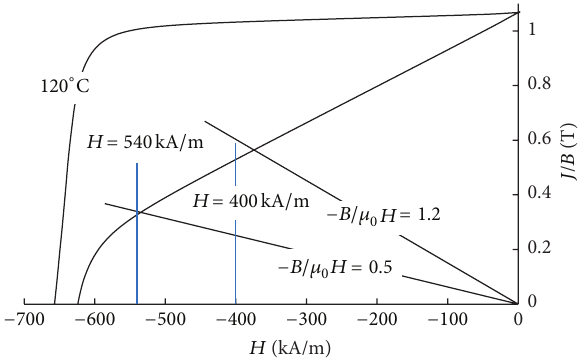
Figure 9: JH and BH curves measured for material 2 at 120 ∘ C. Load lines of 0.5 and 1.2 are also shown.